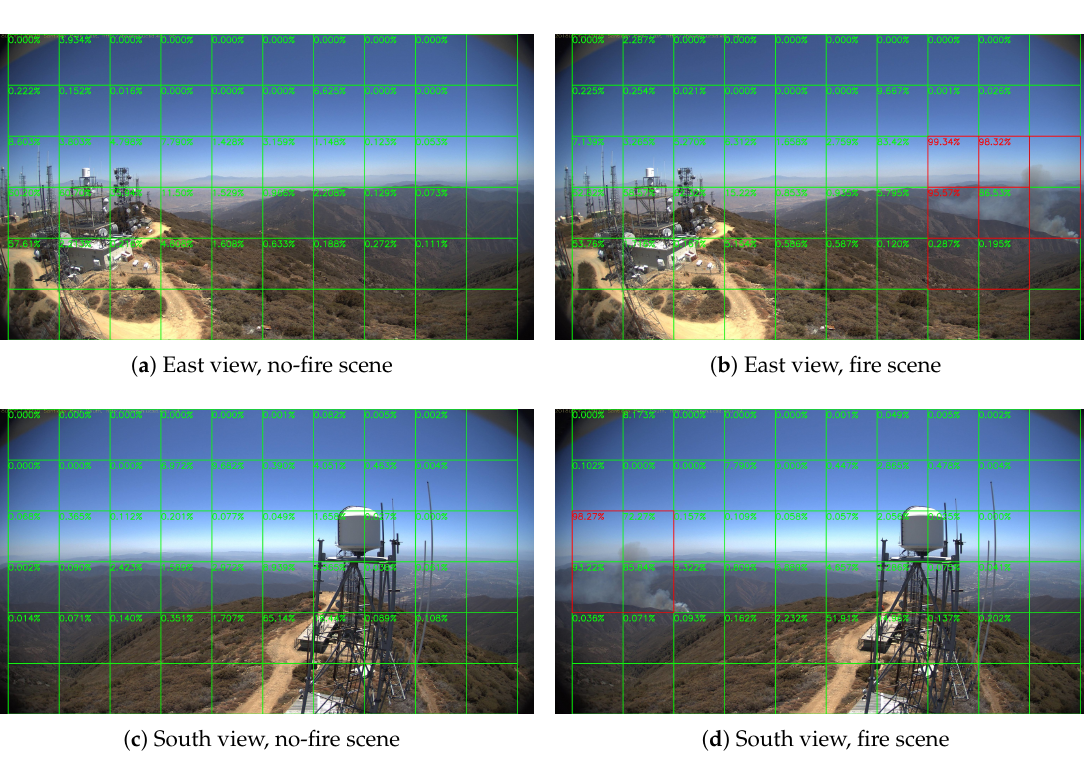
Figure 8. Holy Fire around Santiago Peak, 6 August